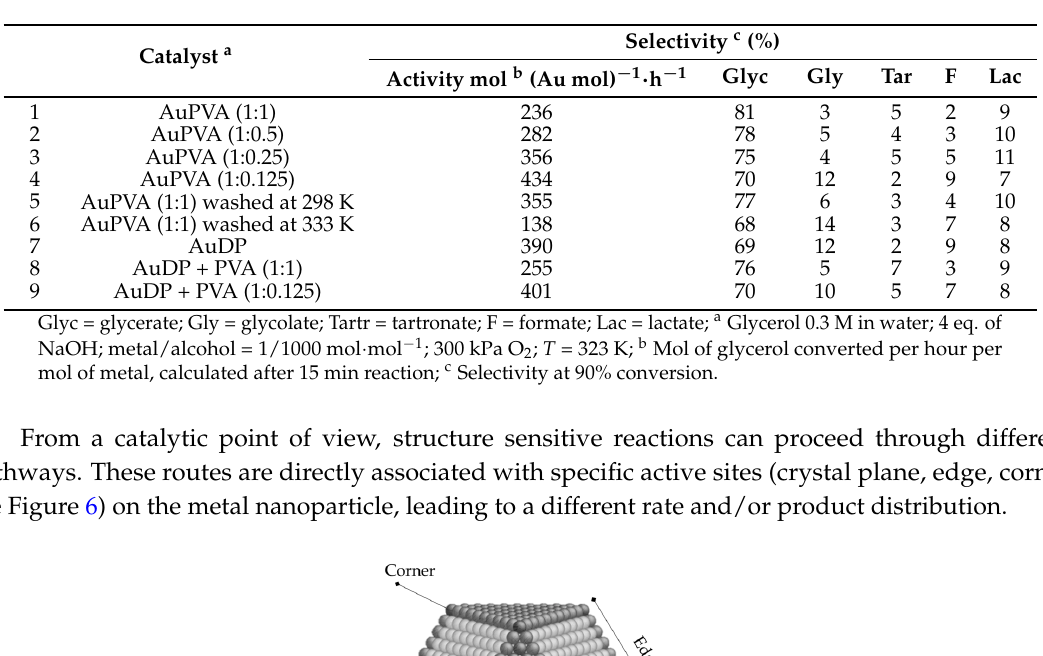
Table 1. Effect of the capping agent amount on the glycerol oxidation (Data from ref. [65] with permission of The Royal Society of Chemistry).